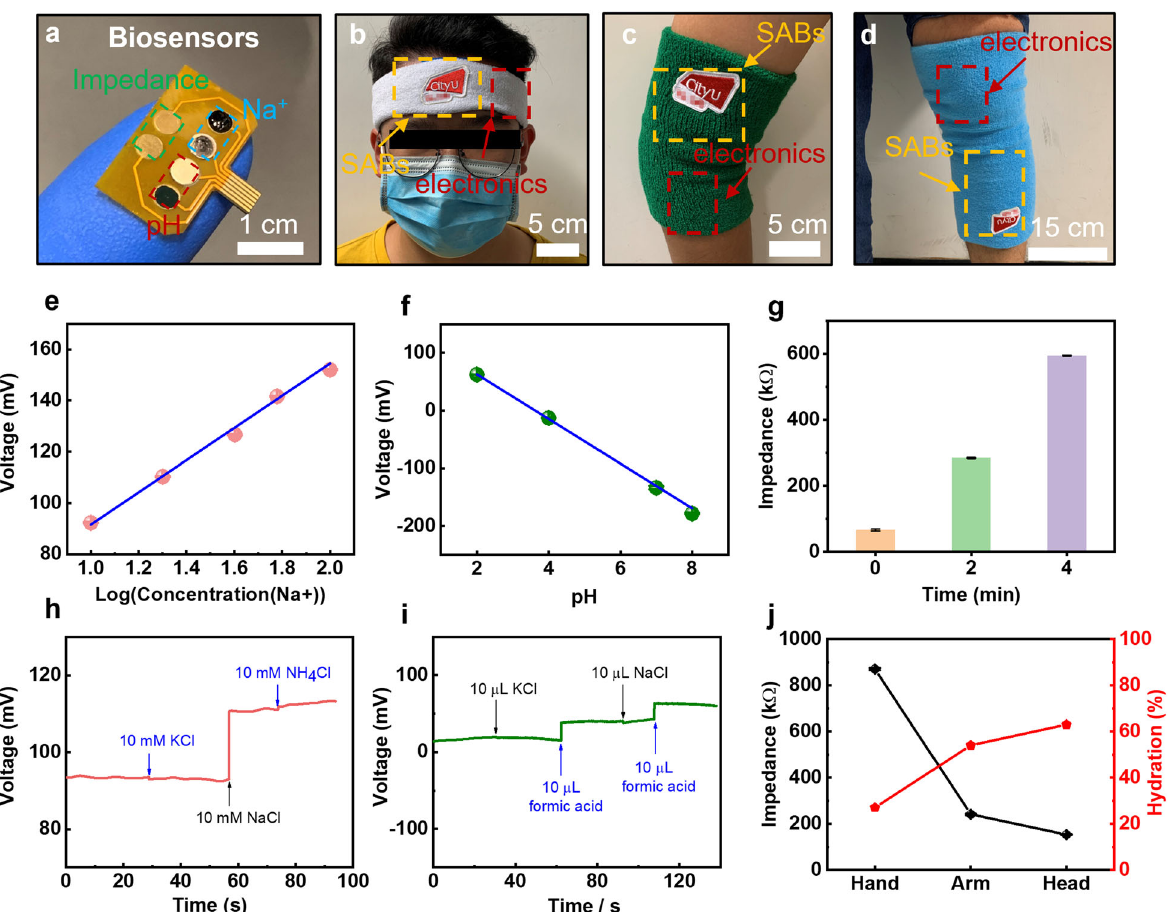
Fig. 3 Multiplexed biosensor patch characterization. a Optical images of the multiplexed biosensor patch. b – d Optical images of SMS embedded in the head band, elbow pad, and knee pad. e , f Calibration curve of the Na + sensor and pH sensor. g The skin impedance changes as a function of time after dropping 10 μ L water. h , i Anti-interference characterization of the Na + sensor and pH sensor. j Results comparison of the skin impedance and commercial hydration